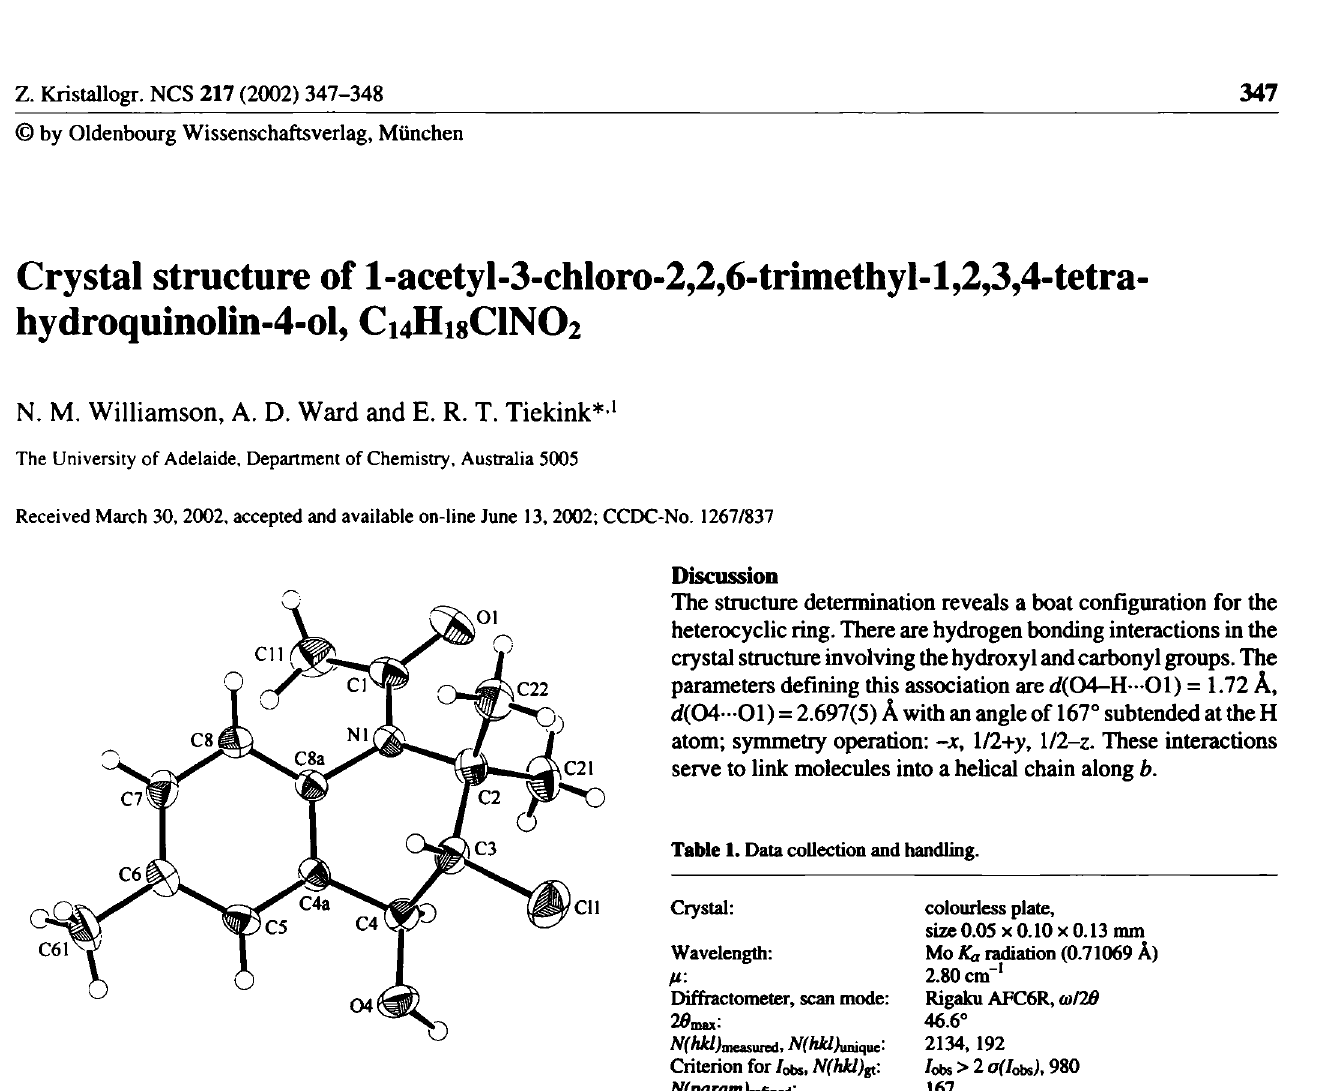
Table 2. Atomic coordinates and displacement parameters (in Â 2